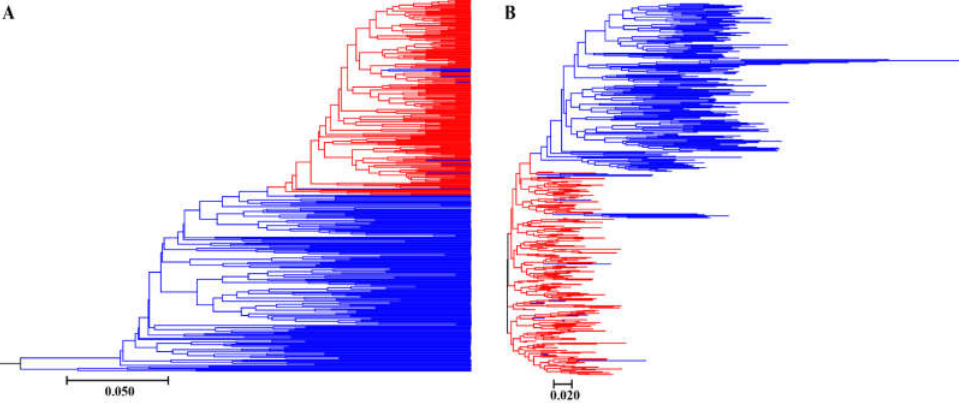
Figure 4. UPGMA dendrogram ( A ) and unrooted neighbor-joining ( B ) trees based on Nei’s (1983) DA distance of self- and open-pollinated offspring. Red lines represent self-pollinated offspring, and blue lines represent open-pollinated offspring.